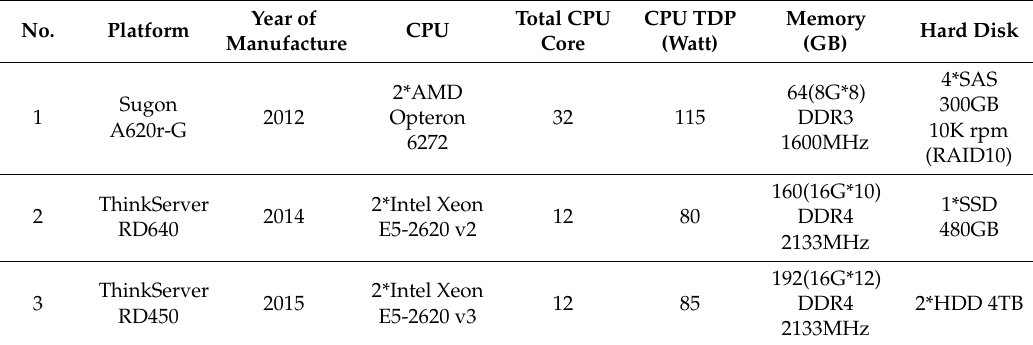
Table 7. Server types and experimental platform configuration.